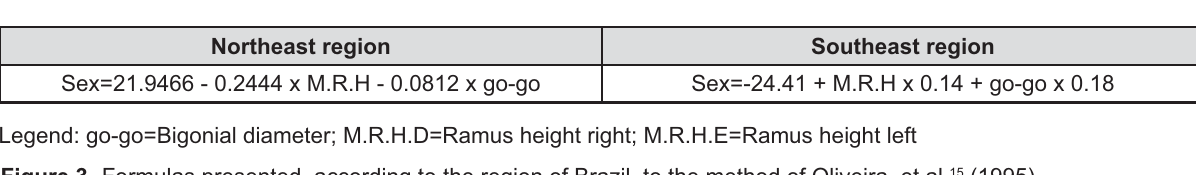
Figure 3- Formulas presented, according to the region of Brazil, to the method of Oliveira, et al. 15